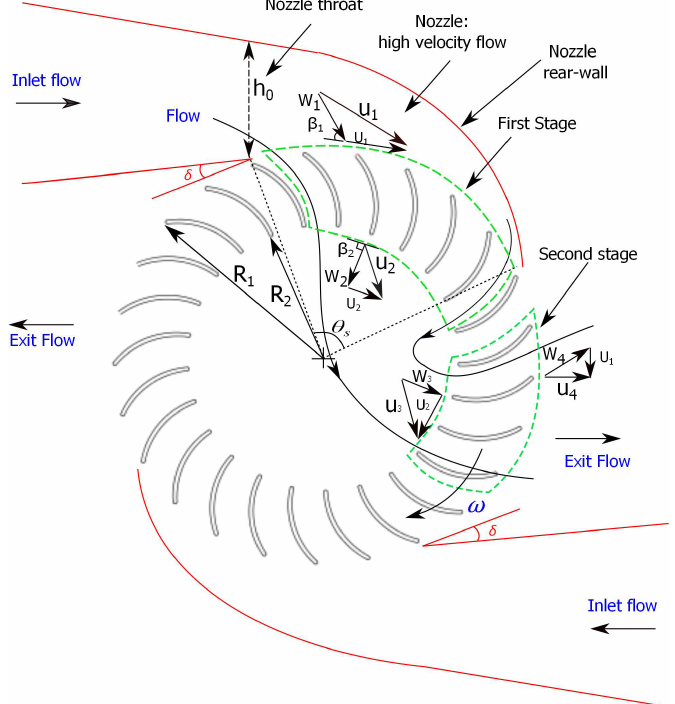
Figure 2. A schematic illustration of a double-nozzle crossflow turbine. Note the anti-symmetric orientation of the nozzles at 180 ◦